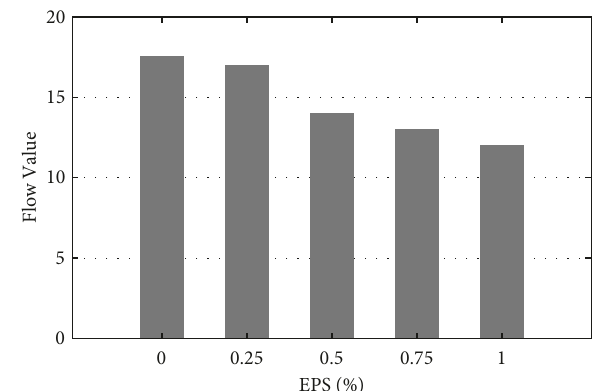
Figure 9: Relationship between stability and EPS.